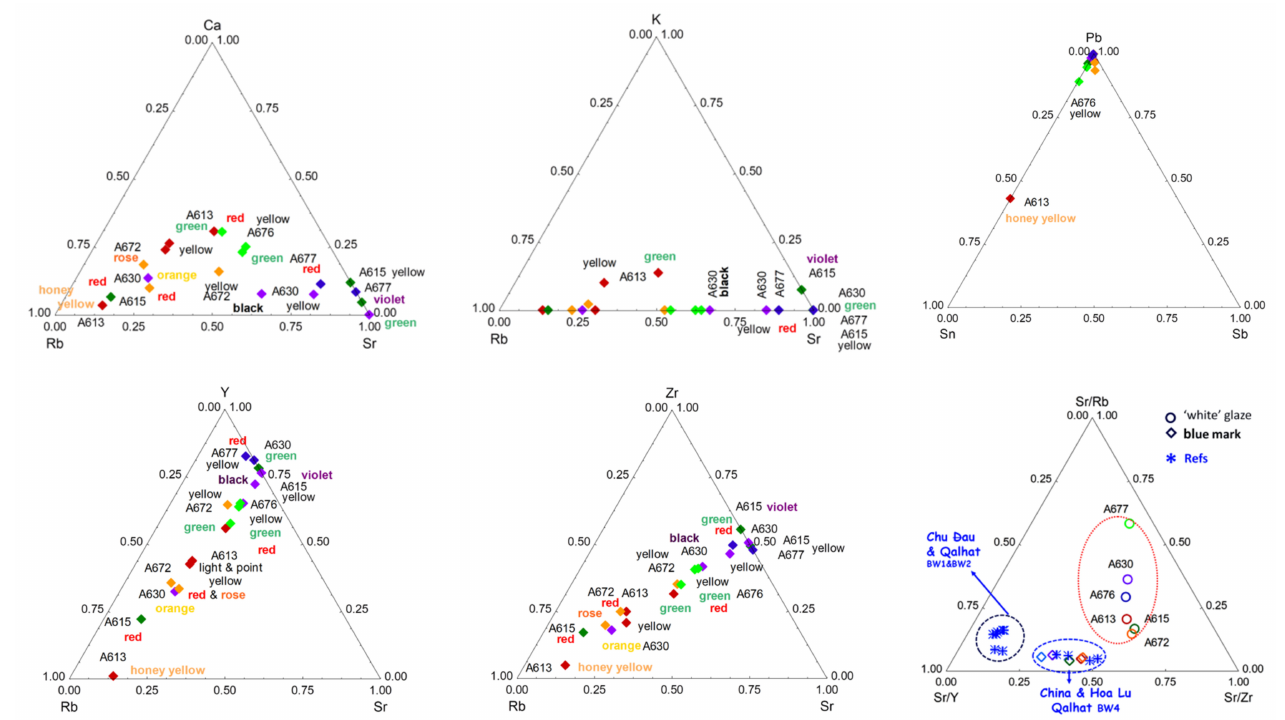
Figure 13. Comparison of the net number of photons of the major (Ca, K) and related trace elements (Y, Rb, Sr, Zr) measured on the colored areas. The data of white and enamel/glaze analyses are plotted separately and compared with the previous data of Chinese and Vietnamese (blue star) artifacts excavated on the kiln site and other places [96–99]. Objects with special characteristics are indicated (see Table 1). See Figure 12 for a labeling explanation.